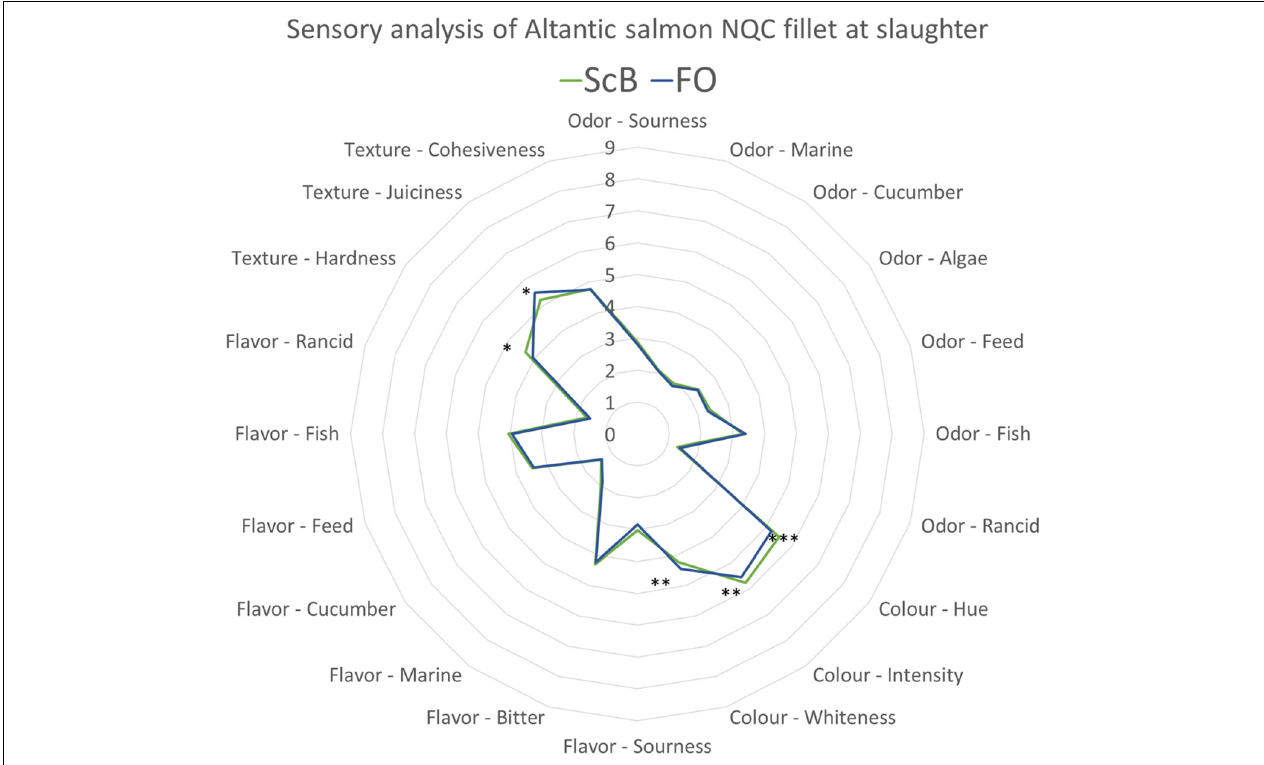
FIGURE 2 | Sensory analysis. Effect of end diets and pre-feeding at slaughter – 4.15 kg mean body weight Atlantic salmon. Comparisons of mean values (Tukey’s test) of evaluation on Atlantic salmon raw filet samples for odor and color and heated (cooked) filets for taste, flavor, and texture at slaughter ( ∗ P < 0.05; ∗∗ P < 0.01; ∗∗∗ P <